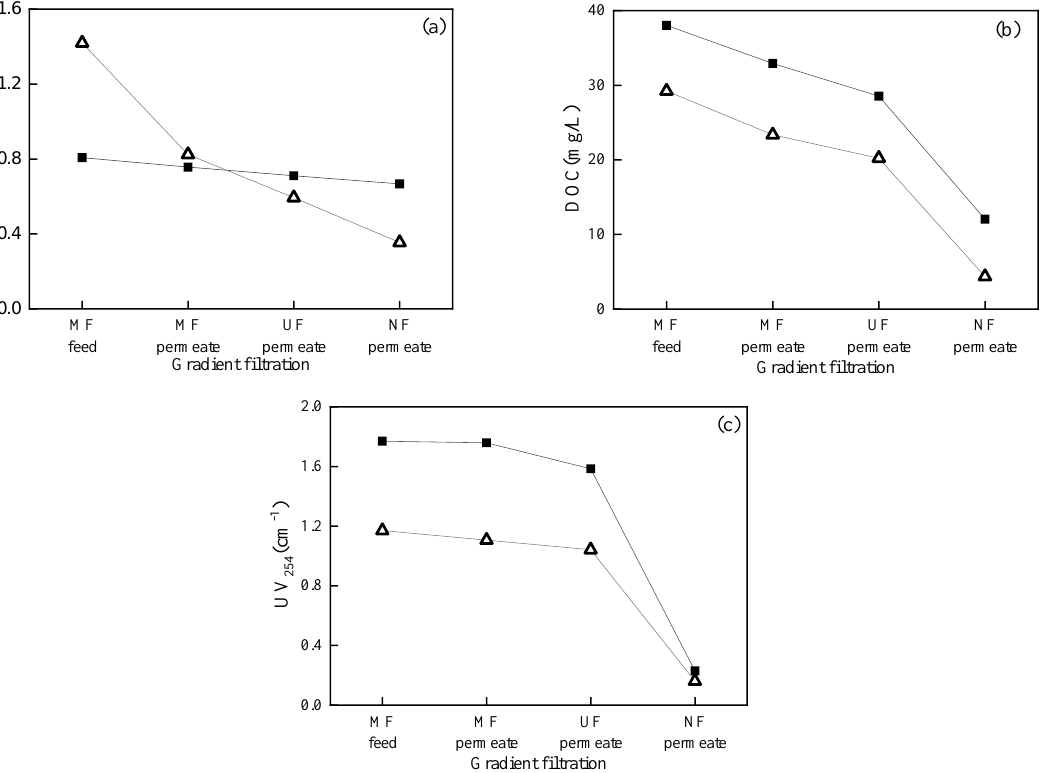
Figure 10. Turbidity ( a ), DOC ( b ), and UV 254 ( c ) during gradient filtration of low- ( △ ) and high-DOC ( ■ ) RWW.